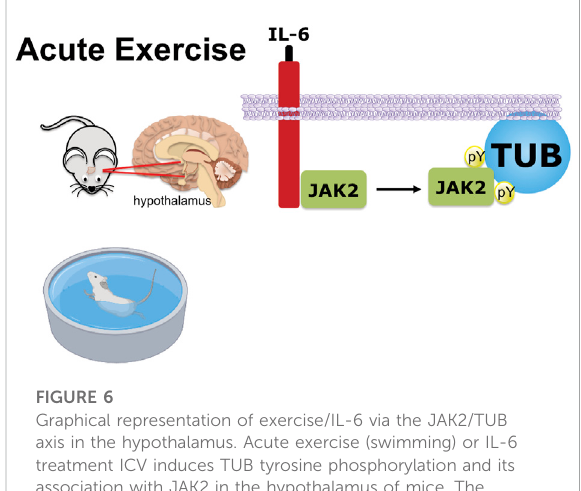
FIGURE 6 Graphical representation of exercise/IL-6 via the JAK2/TUB axis in the hypothalamus. Acute exercise (swimming) or IL-6 treatment ICV induces TUB tyrosine phosphorylation and its association with JAK2 in the hypothalamus of mice. The activation of the IL-6/Tubby axis reduces food intake. Therefore, acute exercise or IL-6 via the activation of the IL-6/JAK2/Tubby axis reduces